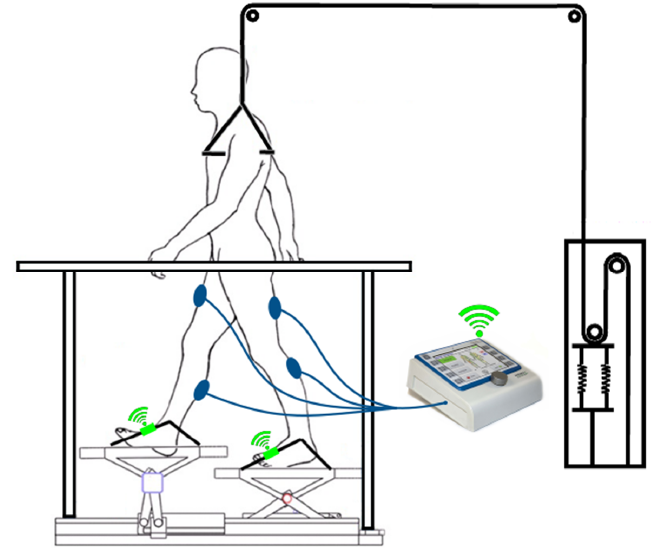
Figure 2. Concept: Lyra with IMUs and FES, adapted from